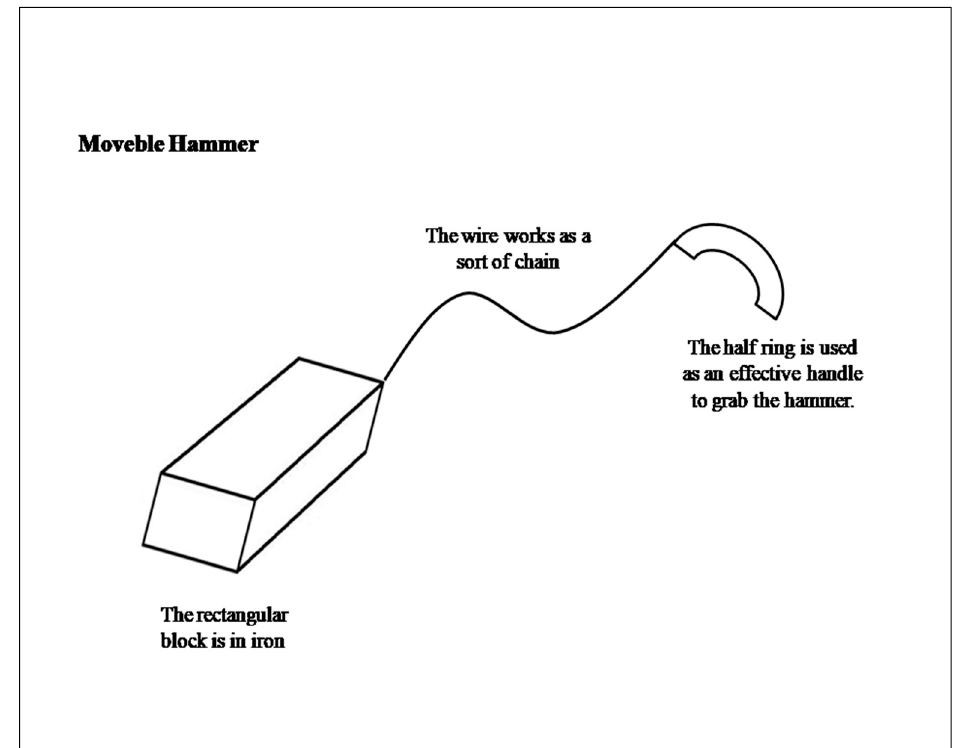
Figure 1. Note: Example of object created.